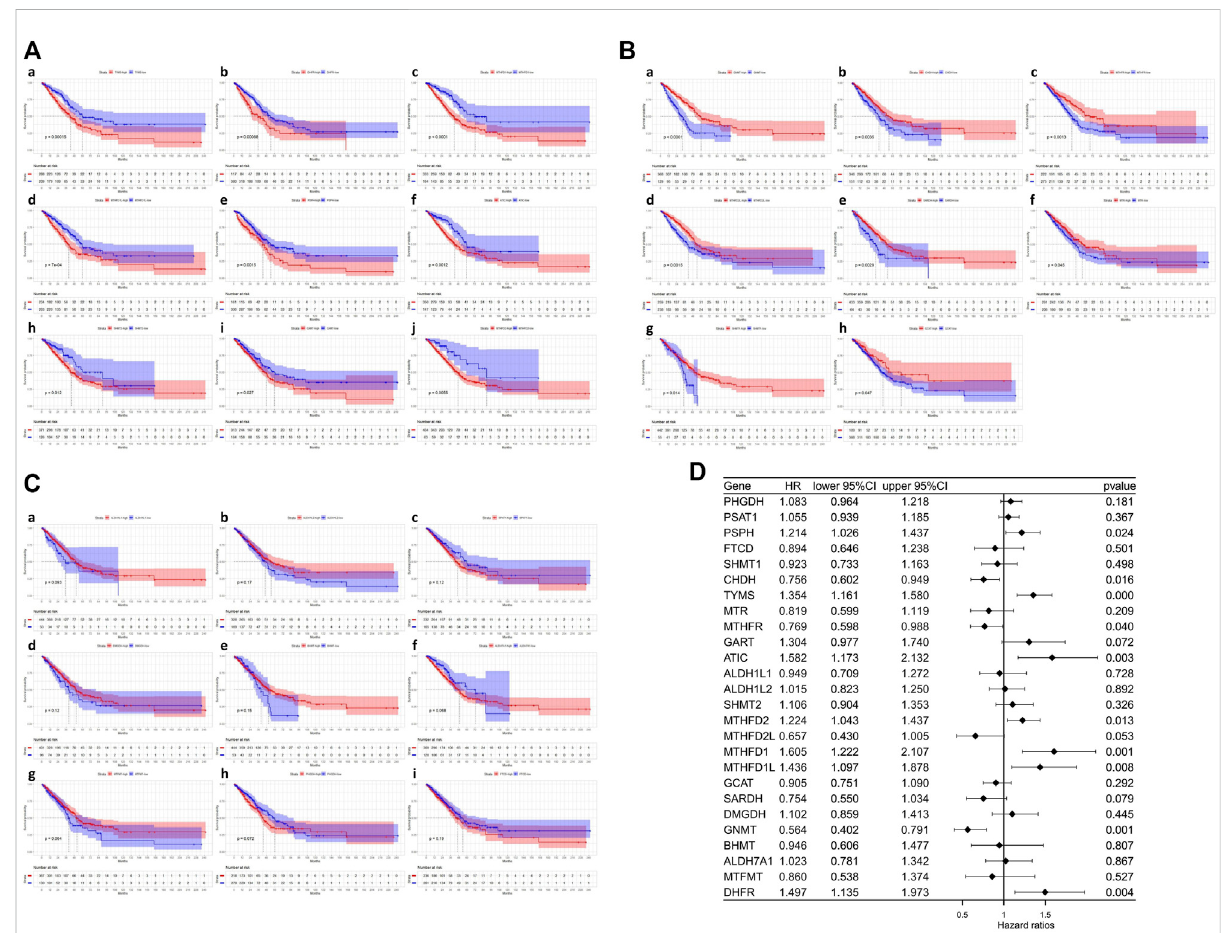
FIGURE 2 Kaplan-Meier survival curves and Univariate Cox regression analysis of one-carbon metabolism associated genes. (A) Kaplan-Meier survival curves of nine genes associated with inferior OS; (B) Kaplan-Meier survival curves of eight genes associated with superior OS; (C) Kaplan-Meier survival curves of nine genes not associated with OS; (D) Univariate Cox regression analysis of 26 one-carbon metabolism associated